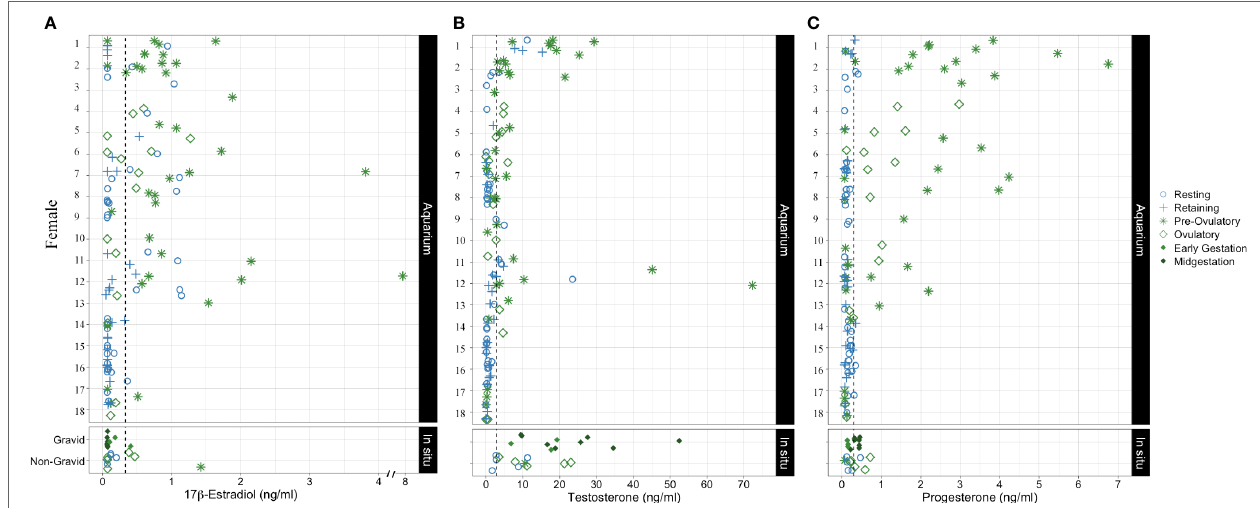
FIGURE 6 | Plasma (A) 17 β -estradiol (B) testosterone and (C) progesterone concentration for aquarium sharks monitored longitudinally in resting and active reproductive years. Each symbol represents a different timepoint for each female. In situ shark data were combined into gravid and non-gravid categories with each symbol representing a single point in time for different females. The shape and color of each point indicate reproductive stage.